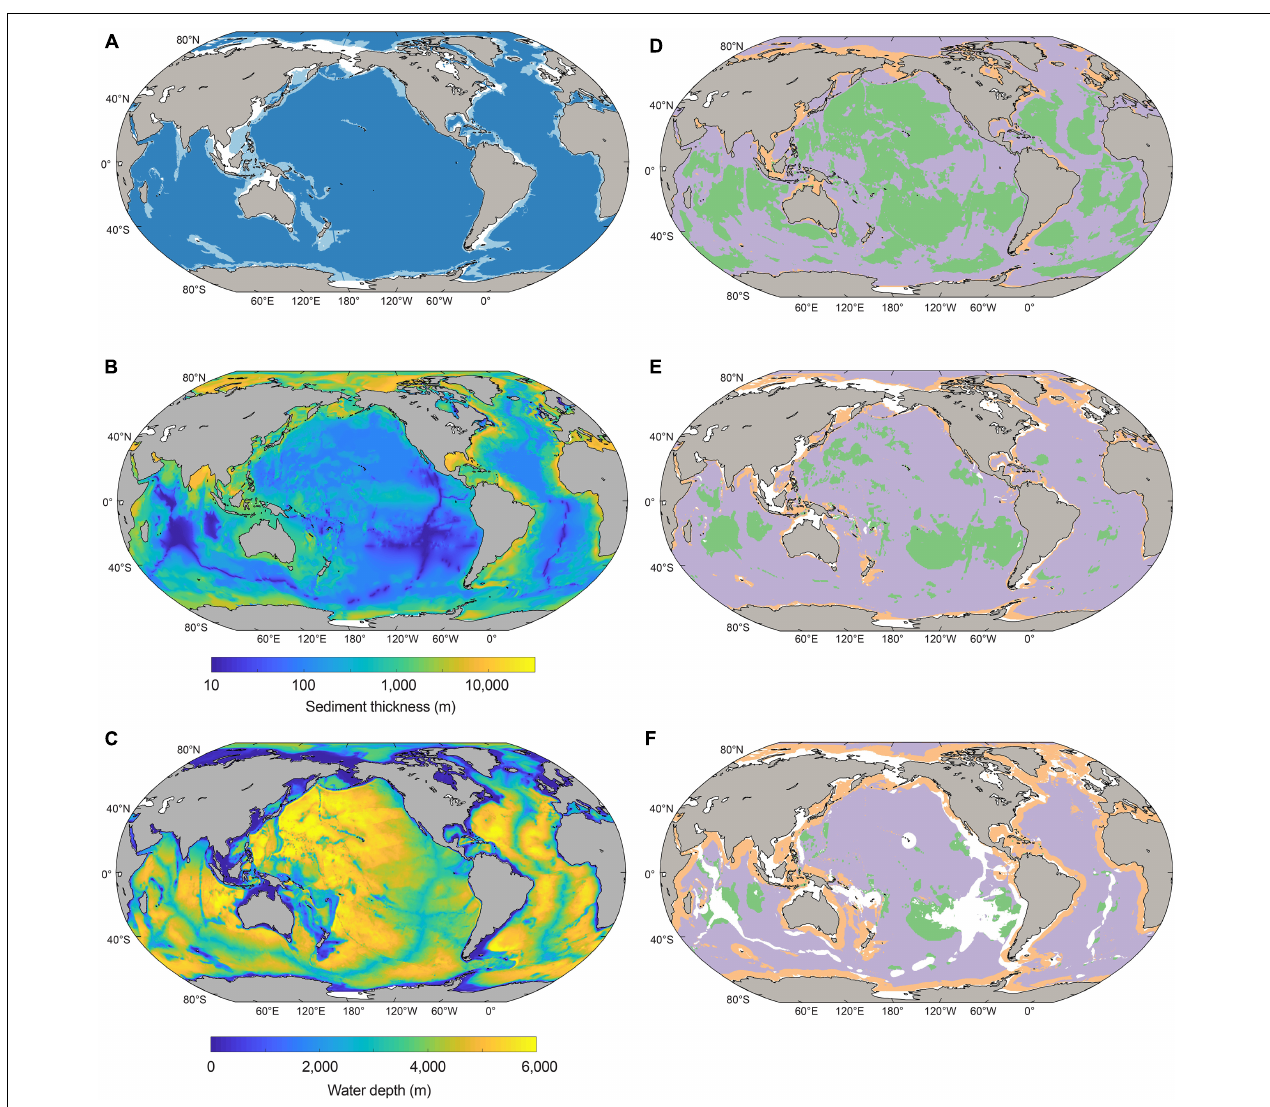
FIGURE 1 | (A) Geographic distribution of the shelf (white), margin (light blue), and abyss (dark blue) sediment domains considered in this study. (B) Sediment thickness (meters). (C) Water depth (meters). (D–F) Global maps depicting the major catabolic pathway of particulate organic carbon (POC) degradation